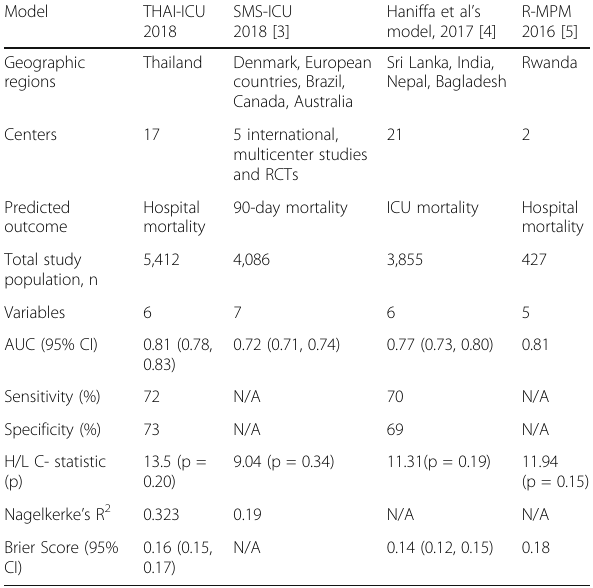
Table 2 (abstract P5). Performance comparison of recently available simplified-ICU severity scores